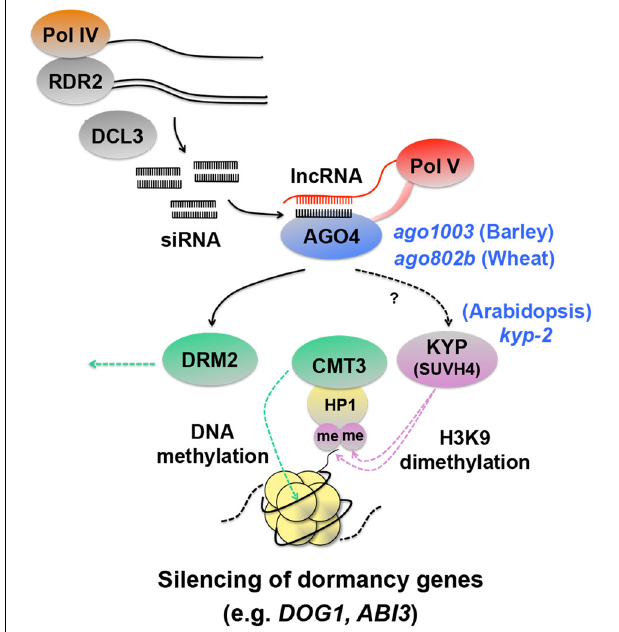
FIGURE 4 | Schematic representation of silencing of dormancy genes through histone and DNA methylation. RNA polymerase IV (Pol IV) transcripts are converted to double-stranded RNA by RNA-Dependent RNA polymerase 2 (RDR2), which are then processed into 24-nt siRNAs by DICER-LIKE3 (DCL3) (Xie et al., 2004; Herr et al., 2005; Onodera et al., 2005; Law et al., 2011). siRNAs are loaded onto ARGONAUTE4 (AGO4) (Qi et al., 2006) and interact with long non-coding RNAs (lncRNAs) produced by Pol V, which are thought to function as scaffold transcripts to guide siRNAs to specific loci to be silenced (Wierzbicki et al., 2008, 2009; Wierzbicki, 2012). In this way, the AGO4 complex containing siRNAs and lncRNAs triggers RNA-directed DNA methylation (RdDM) (Wierzbicki, 2012). A possible event downstream of AGO4 is histone 3 lysine 9 dimethylation (H3K9me2) by the KRYPTONITE (KYP), which causes HETEROCHROMATIN PROTEIN1 (HP1) to bind to the modified histone and recruit CHROMOMETHYLASE3 (CMT3), a DNA methyltransferase that induces gene silencing (Jackson et al., 2002; Zilberman et al., 2004; Tran et al., 2005; Johnson et al., 2007). A mutation in KYP in Arabidopsis causes enhanced dormancy and up-regulation of DOG1 and ABI3 (Zheng et al., 2012), suggesting that the seed dormancy genes are silenced by the KYP-CMT3 pathway. The AGO4 complex is also involved in gene silencing by DOMAINS REARRANGED METHYLTRANSFERASE2 (DRM2) (Zilberman et al., 2004; Wierzbicki, 2012), although DRM2 involvement in seed dormancy regulation is not known. Direct evidence for siRNAs and lncRNAs involvement in DOG1 and ABI3 regulation is lacking, however AGO4 has been shown to be a negative regulator of dormancy in barley and wheat seeds (Singh and Singh, 2012; Singh et al., 2013). The Arabidopsis, barley and wheat seed dormancy mutants corresponding to the protein components in the RdDM pathway are indicated by blue italic